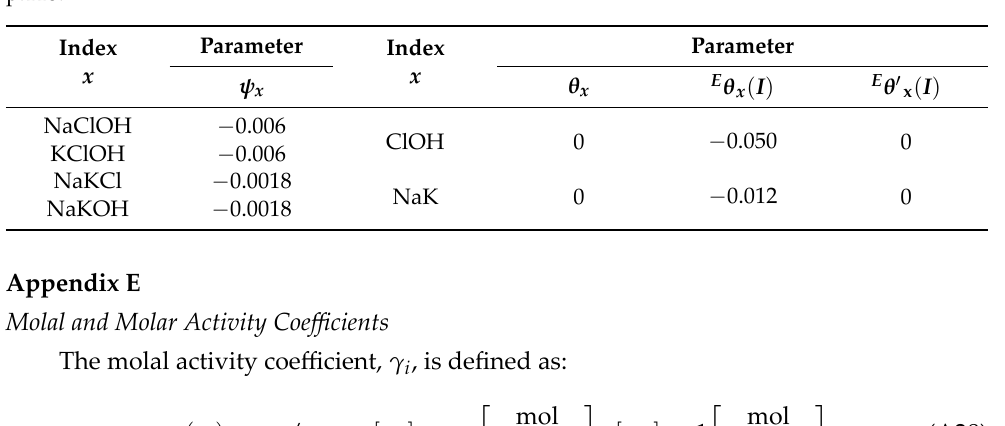
Table A3. Pitzer model third‑order parameters for Equations (26), (A1), and (A2). [69], Table 18,